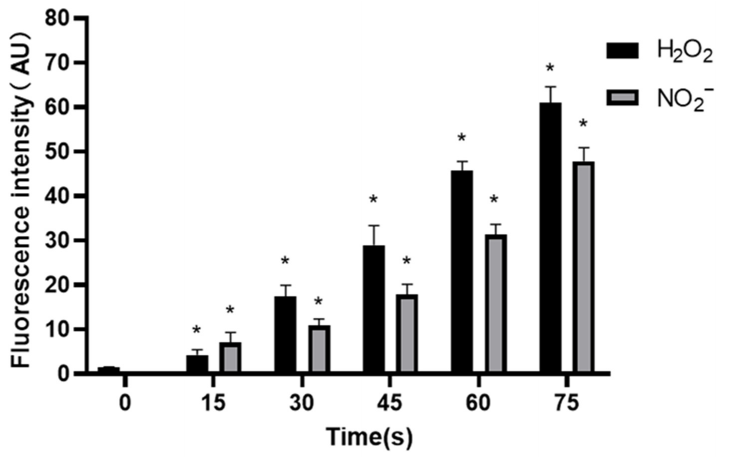
Figure 8. Concentrations of H 2 O 2 and NO 2 − in PAM, * compared with control group (0 s) p < 0.05.